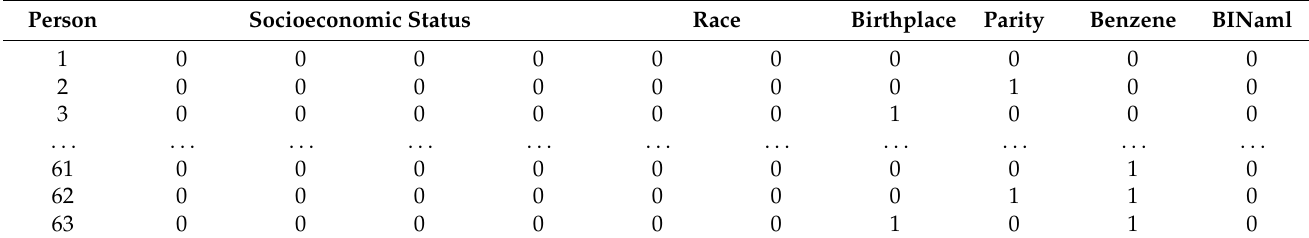
Table 1. Factuals and counterfactuals input for the ATE model.